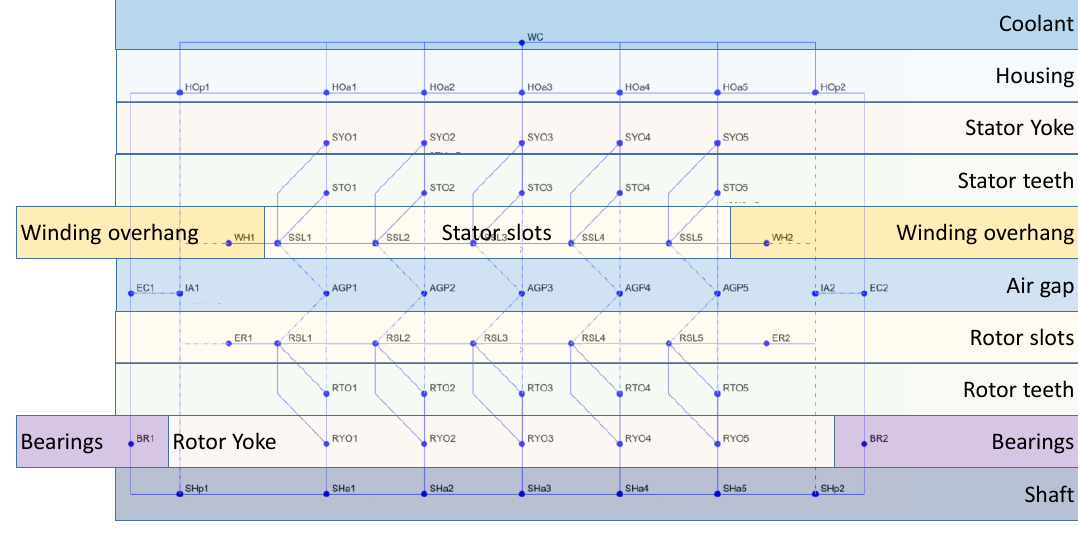
Figure 8. Overview of thermal network.